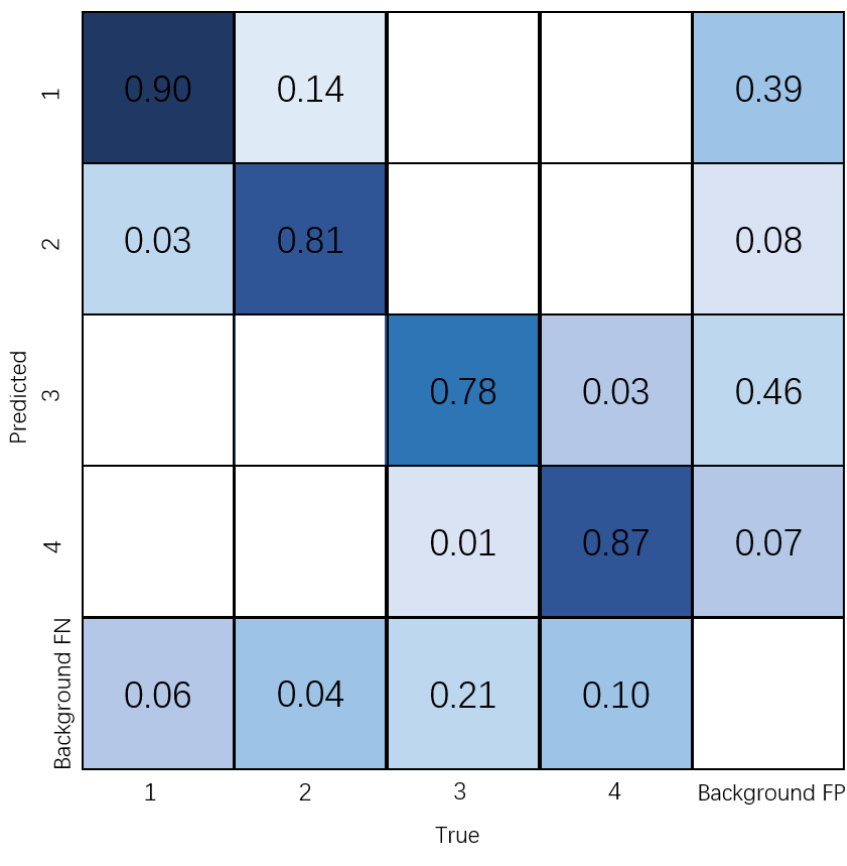
Figure 16. Confusion